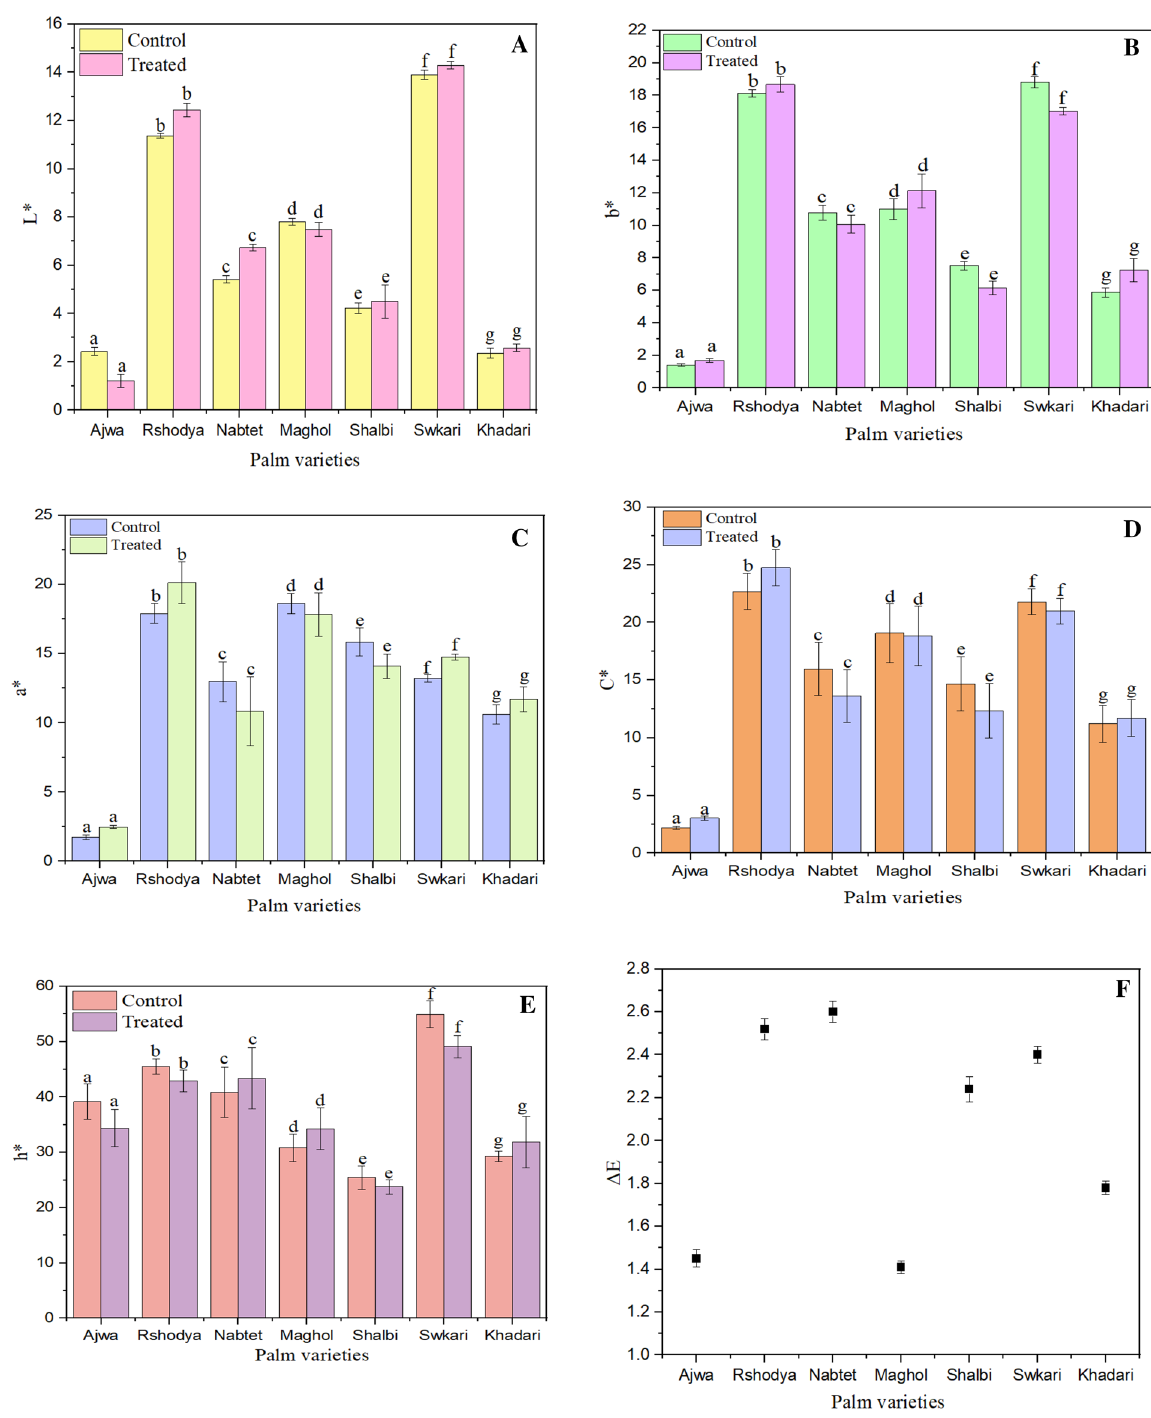
Figure 7. The impact of SDBD on color parameter of palm dates; ( A ) L*, P value = 0.08, ( B ) b*, P value = 0.76, ( C ) a*, P value = 0.82 ( D ) c*, P value = 0.74 ( E ) h*, P value = 0.57 and ( F )